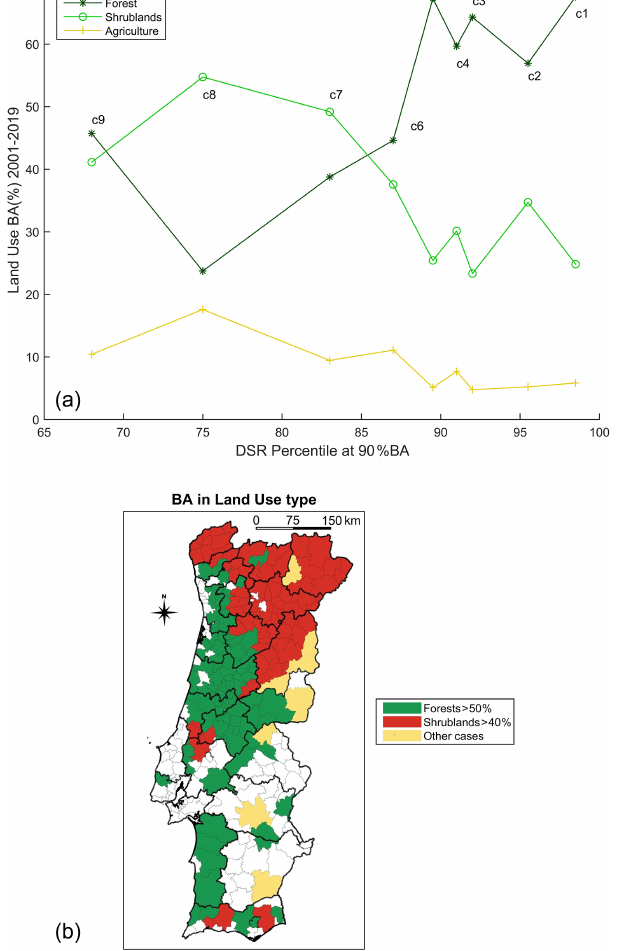
Figure 11. (a) Burnt area (BA) in three land use types: forest, shrub- lands and agriculture; represented for each cluster, identified by the respective DSRp and also by the letter c. (b) Municipalities with burnt area in forest > 50%, shrublands > 40% or other cases. Mu- nicipalities without colour were excluded from the cluster